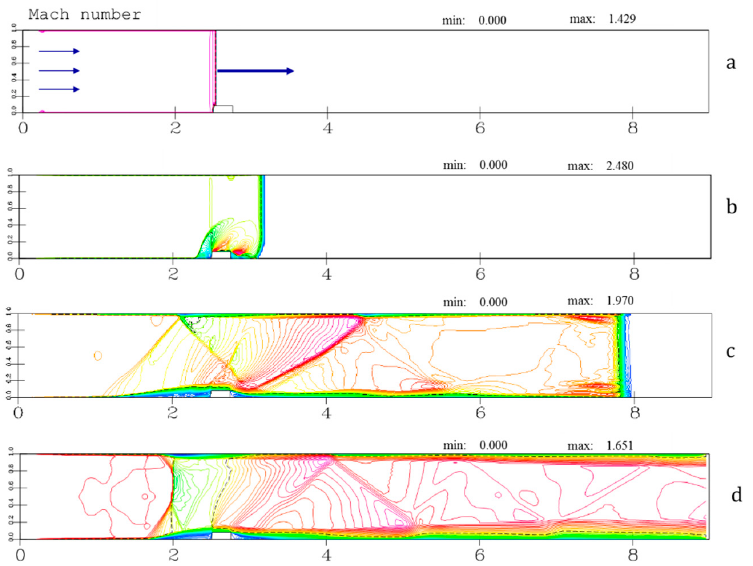
Figure 4. The flow fields of the local Mach number at the shock wave diffraction by an obstacle at 1 ( a ), 10 ( b ), 120 ( c ), 380 µ s ( d ) after the contacting the obstacle (from top to bottom). Mach number of shock wave is 3.20, initial air density is 0.03 kg/m 3 . Arrows indicate the direction of incoming shock wave and the direction of co-current flow. Sonic lines (M l = 1) are shown in dashed